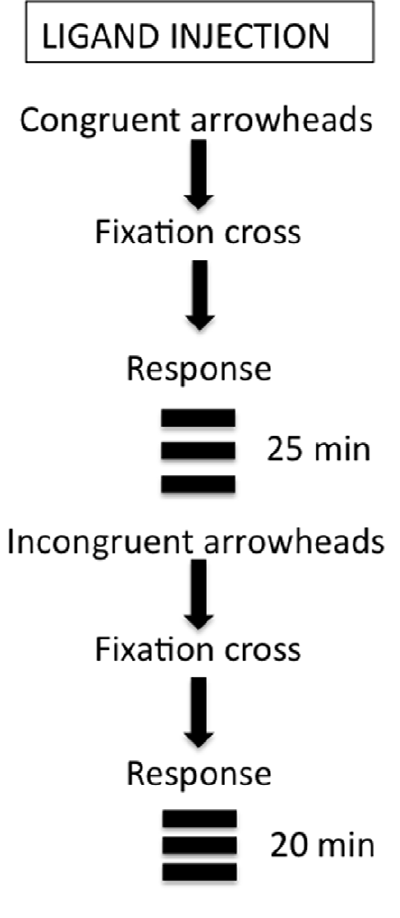
Figure 3. Schematic diagram of the sequence of events.